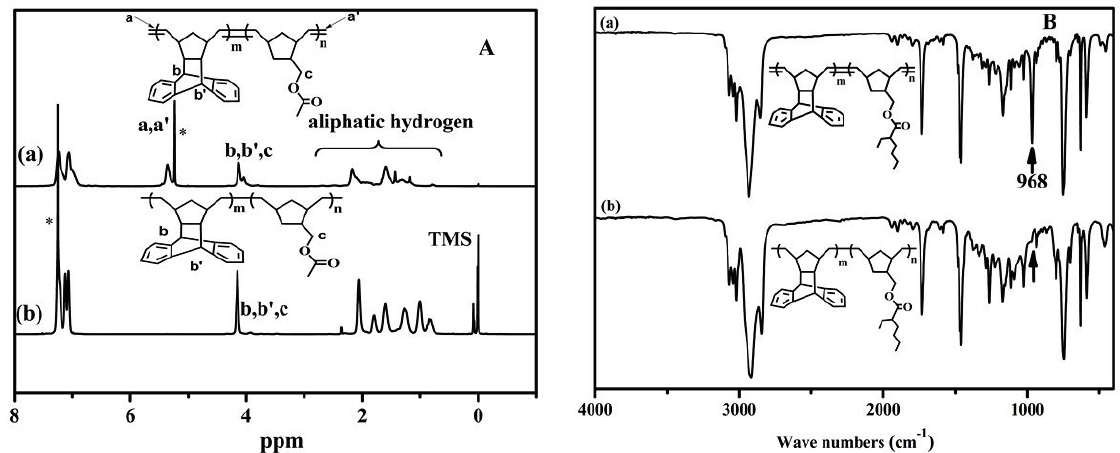
Figure 1. ( A ) 1 H NMR spectra of copolymers: (a) poly(HBM- co -NMA)(90:10), * signals from CD 2 Cl 2 , and (b) corresponding hydrogenated copolymer, * signals from CDCl 3 ; and ( B ) FT-IR spectra of copolymers: (a) poly(HBM- co -NME)(85:15), and (b) corresponding hydrogenated